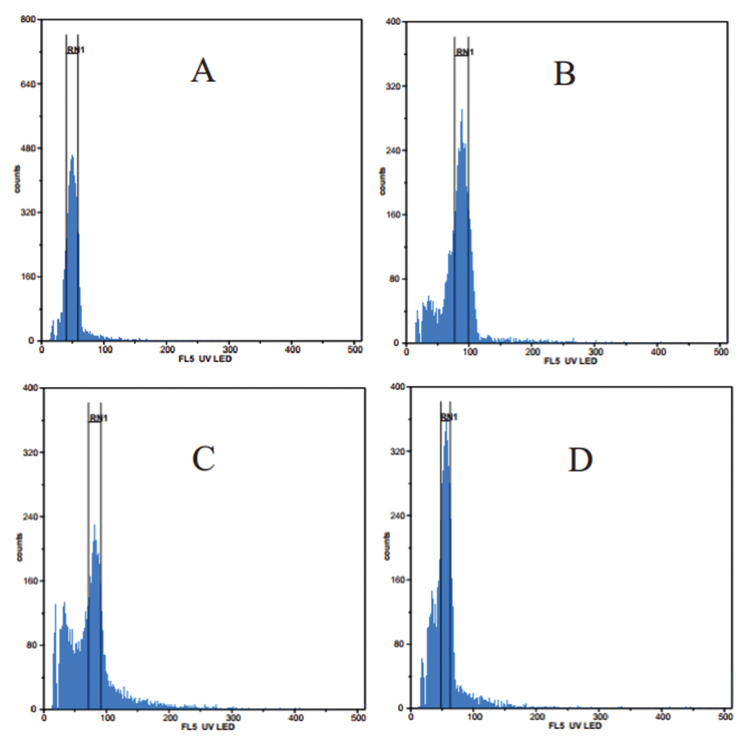
Histogram of relative DNA content of nuclei isolated from the leaves of the new plant and related Hedychium species. AH.coronarium (control) BH.viridibracteatumCH.villosumvar.tenuiflorumDH.villosumvar.villosum.